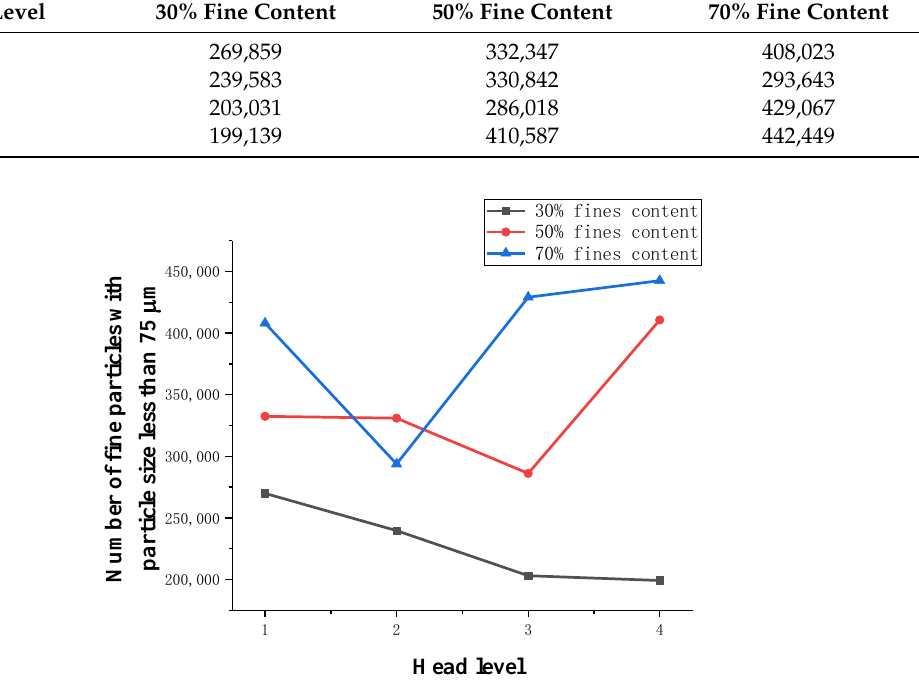
Figure 19. Fine particle content as a function of the number of infiltration processes.